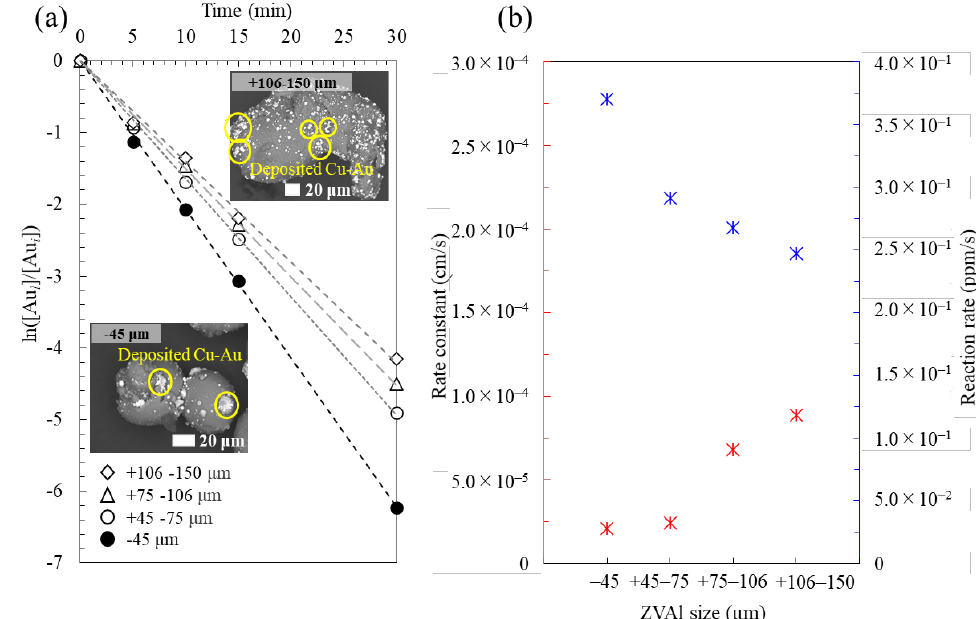
Figure 2. ( a ) The effects of Al particle size (i.e., − 45, +45 − 75, +75 − 106, +106 − 150 µ m) on recovery of Au ions with the SEM photomicrographs, and ( b ) the plot of rate constant/rate vs Al size for the cementation reaction by galvanic interaction of Al and AC in an ammonium thiosulfate system (Note that reaction rate has a minus value). Table 2. Summary of rate constant for the cementation of Au onto the Cu-AC-Al as a function of electron donor (Al) size (base conditions: 10 mL solution containing 1 M of Na 2 S 2 O 3 , 0.5 M of NH 3